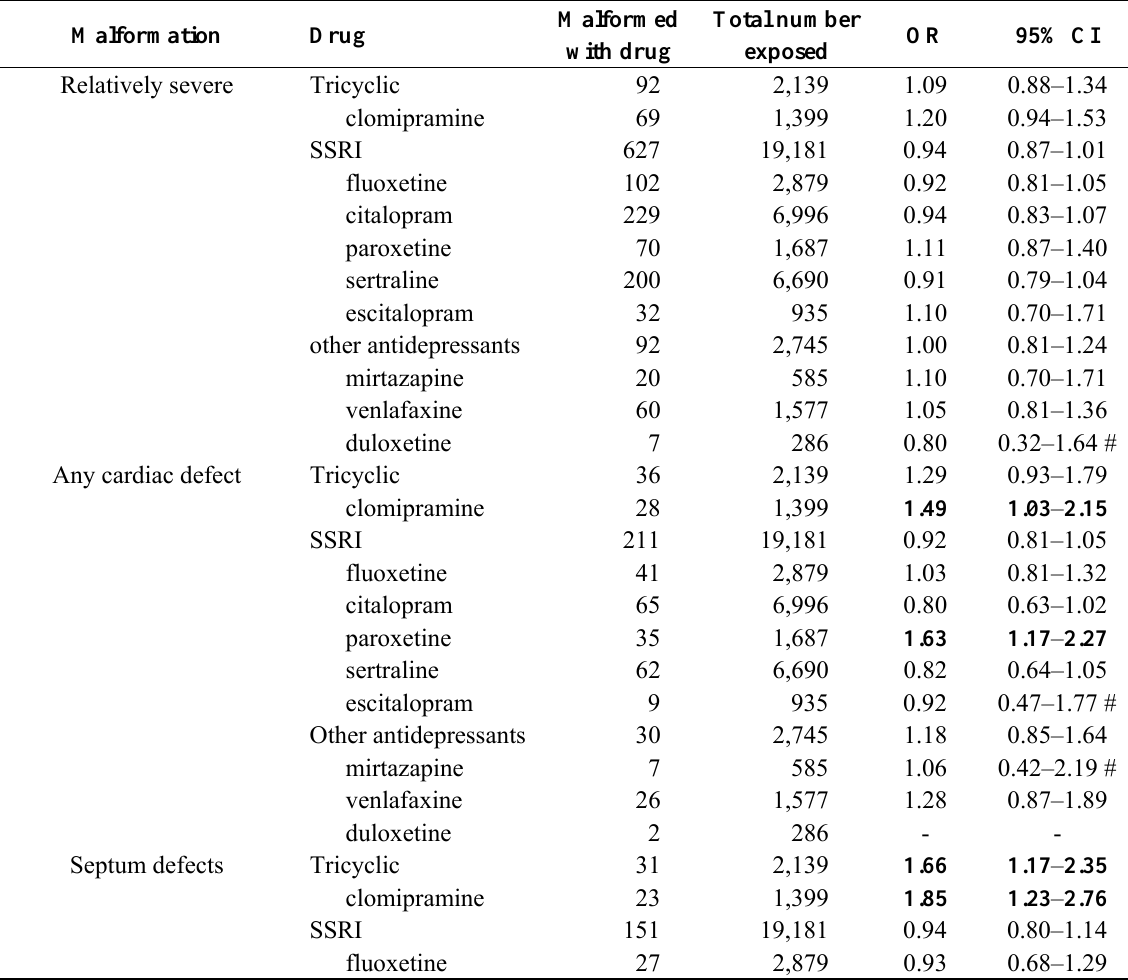
Table 35. Associations between specific antidepressant groups or drugs and some groups of malformations. Bold text marks statistical